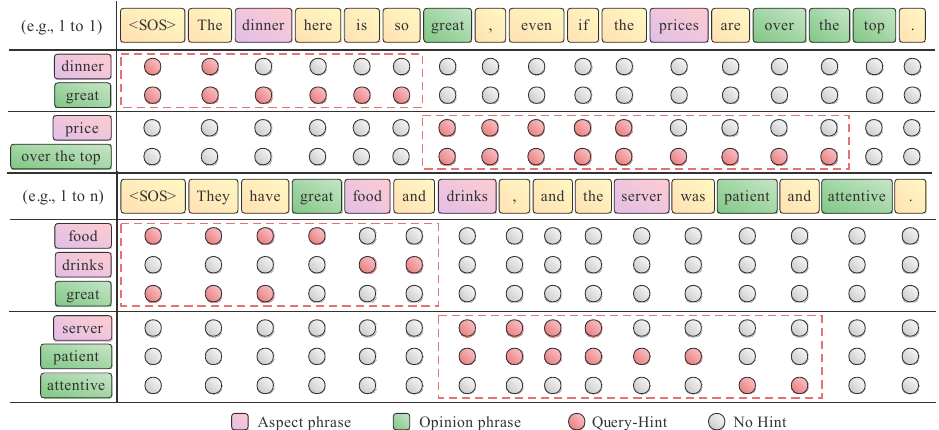
Figure 5. Strategy of the query-hint mechanism, this illustration demonstrates two different instances of query-hint strategy, i.e., “1 to 1” and “1 to n ,” which correspond to the one-to-one and one-to-many situations for aspect-opinion pairs,